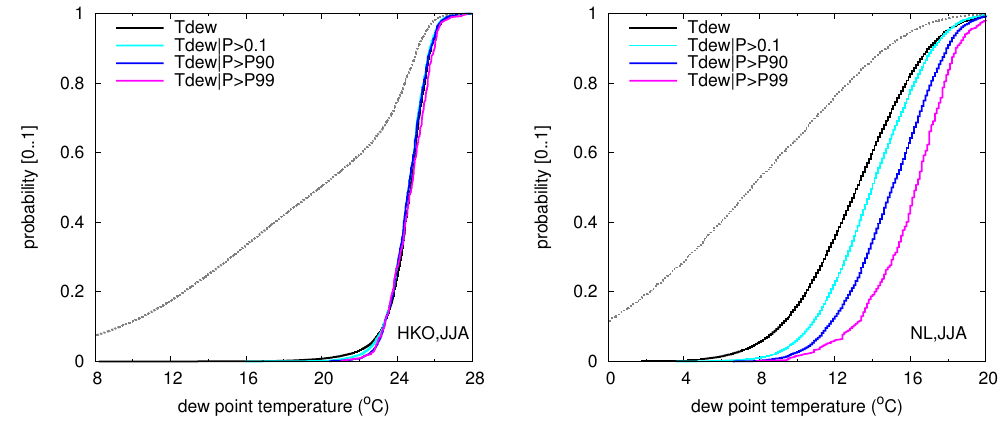
Fig. 3. Cumulative Density Function (CDF) of the dew point temperature for summer (JJA). Distributions of the dew point temperature are plotted for all hours (black line), for hours with precipitation (cyan), and for hours with precipitation exceeding the 90th (blue) and 99th (magenta) percentile of hourly precipitation. As in Fig. 2 dew point temperatures are taken 4h before the precipitation event. The grey stippled line gives the CDF of all hours for the whole year.